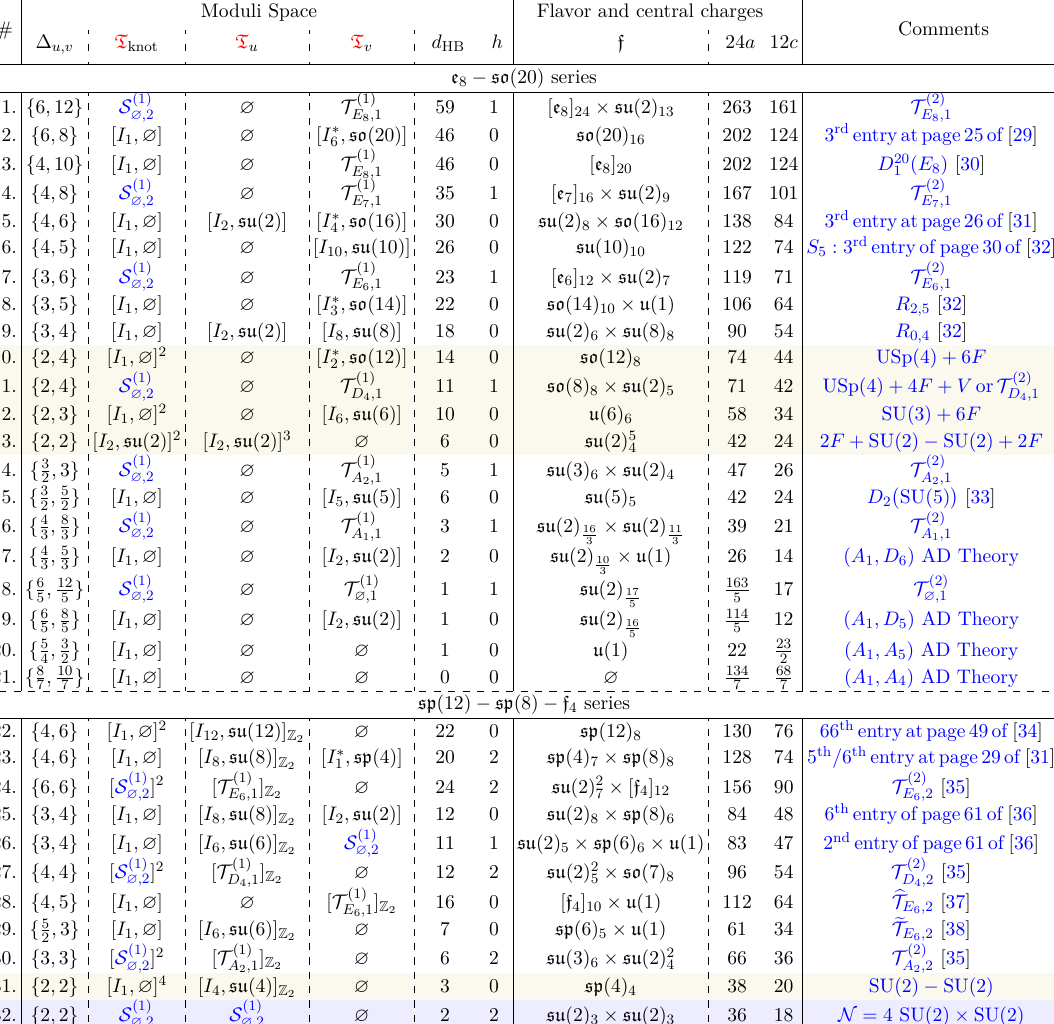
Table of Rank-2 theories: CFT & Coulomb branch data I